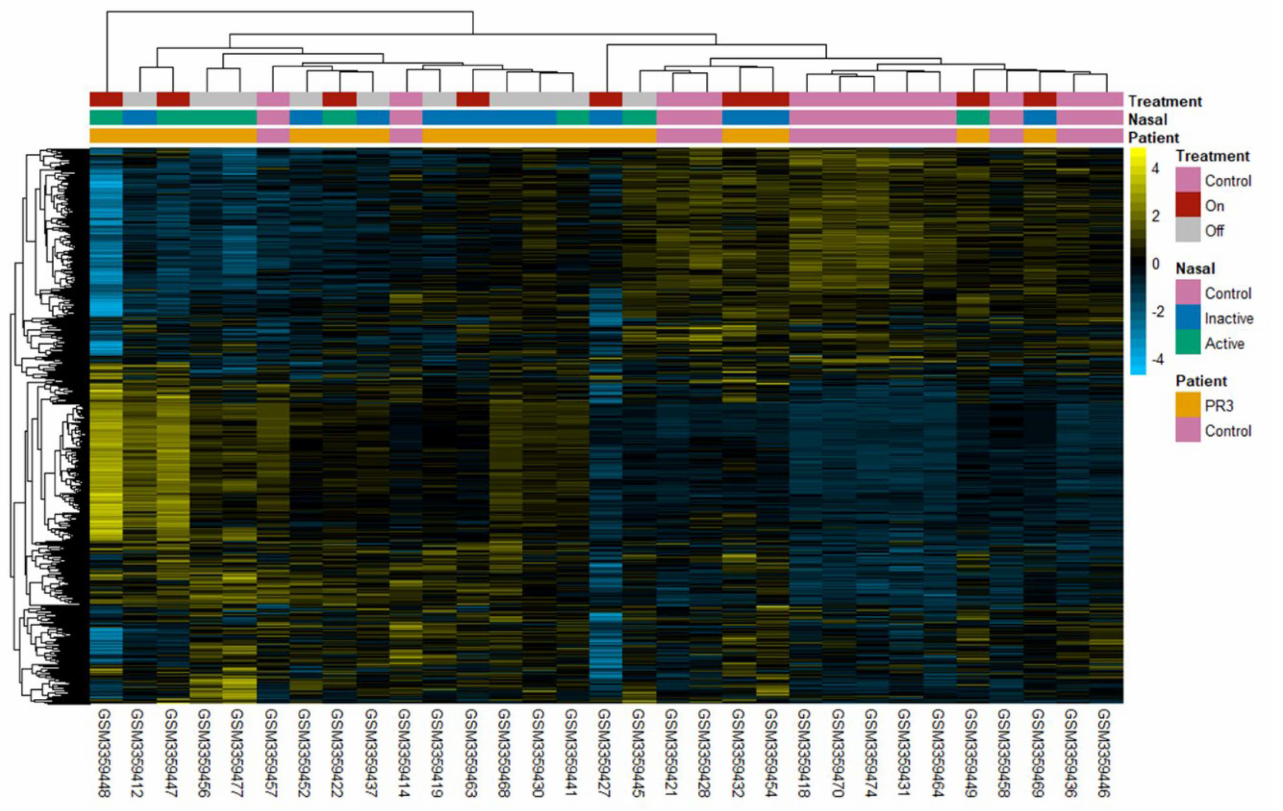
Figure 2. Expression heatmap of disease network genes. Disease network genes (rows) and PR3+ patients (columns) were hierarchically clustered using the Euclidean distance. Gene expression was scaled across samples with yellow/blue representing high/low expression (as shown in the key). Patient groupings were annotated using three colour bars. Healthy controls were shown in pink for all classifications. The top colour bar shows patients on/off treatment in red/grey. The middle colour bar shows patients nasal disease activity with active nasal disease in green and inactive in blue. The bottom colour bar shows disease status with GPA patients shown in